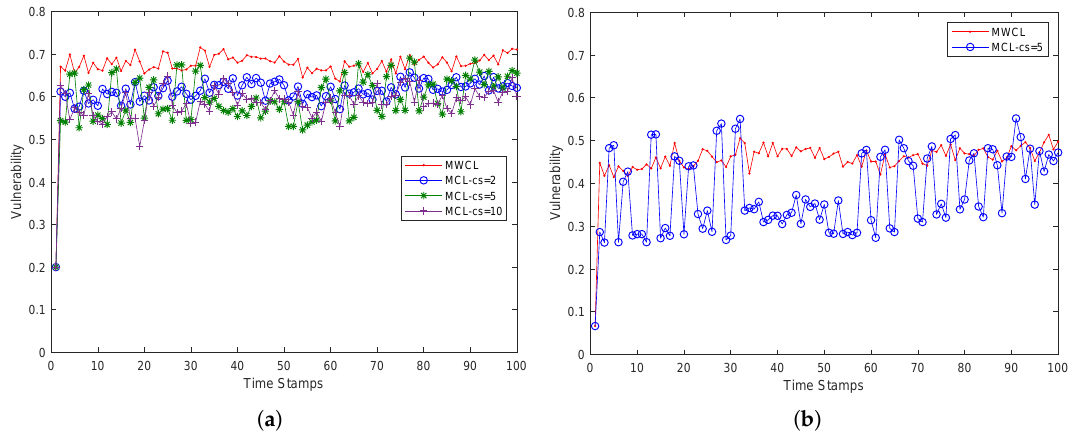
Figure 8. Clustering ( x , y , g , v ) and k -NN x for N = 400 trajectories, L = 100 time-stamps for ( a ) k = 5 and ( b ) k = 15.